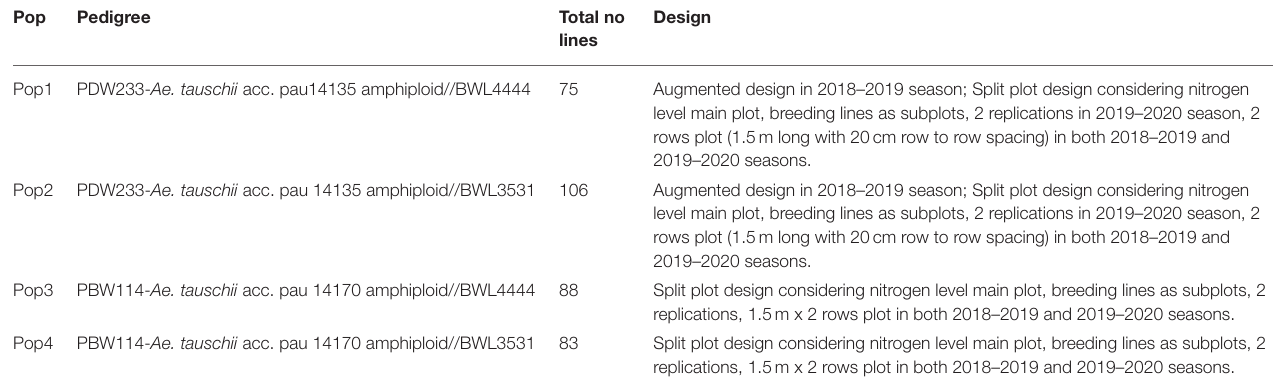
TABLE 1 | Details on experimental material evaluated for nitrogen use efficiency related traits and design used across two crop seasons (2018–2019 and 2019–2020). Pop Pedigree Total no